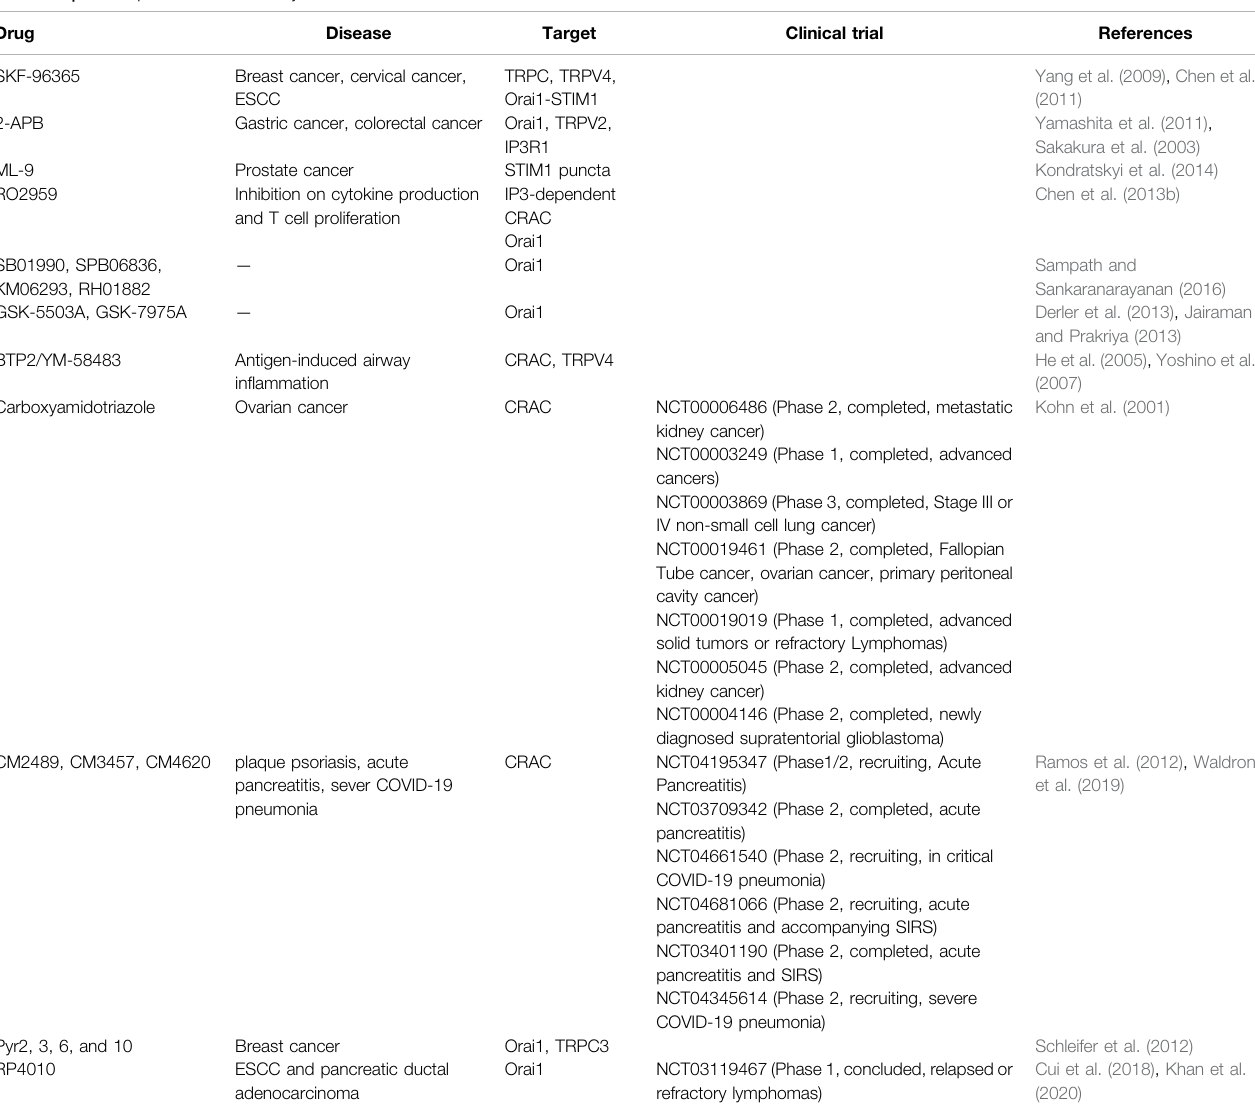
TABLE 1 | Store-operated calcium entry inhibitors. Drug